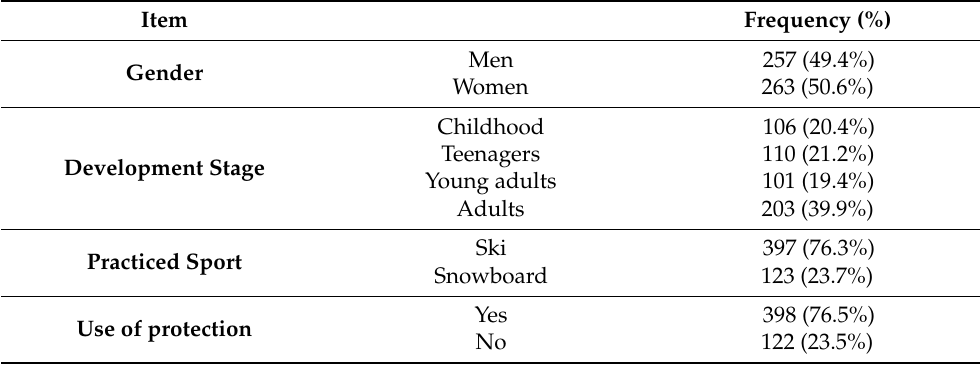
Table 1. Sample’s characterization.